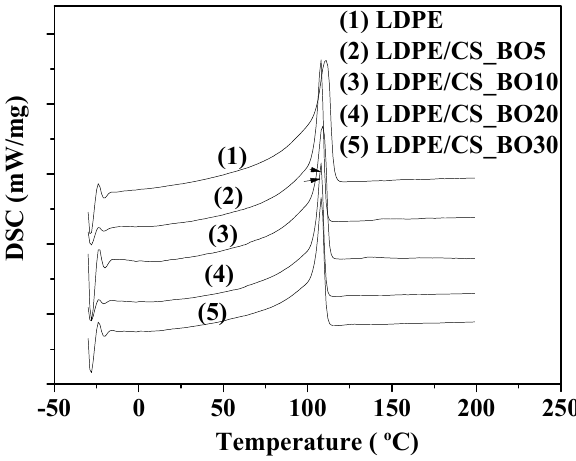
Figure 4. DSC curves of pure LDPE and LDPE/CS_BO composites.